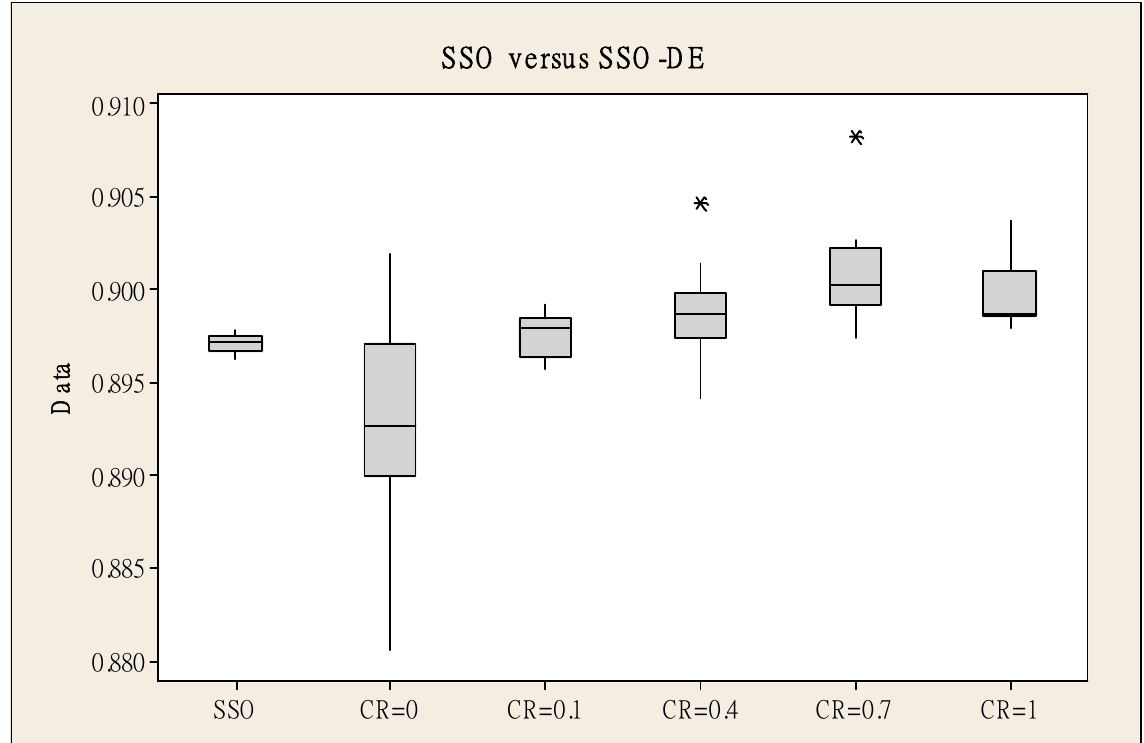
Figure 8. Box and whisker diagram of SSO and SSO-DE for summer. *: Outliers.